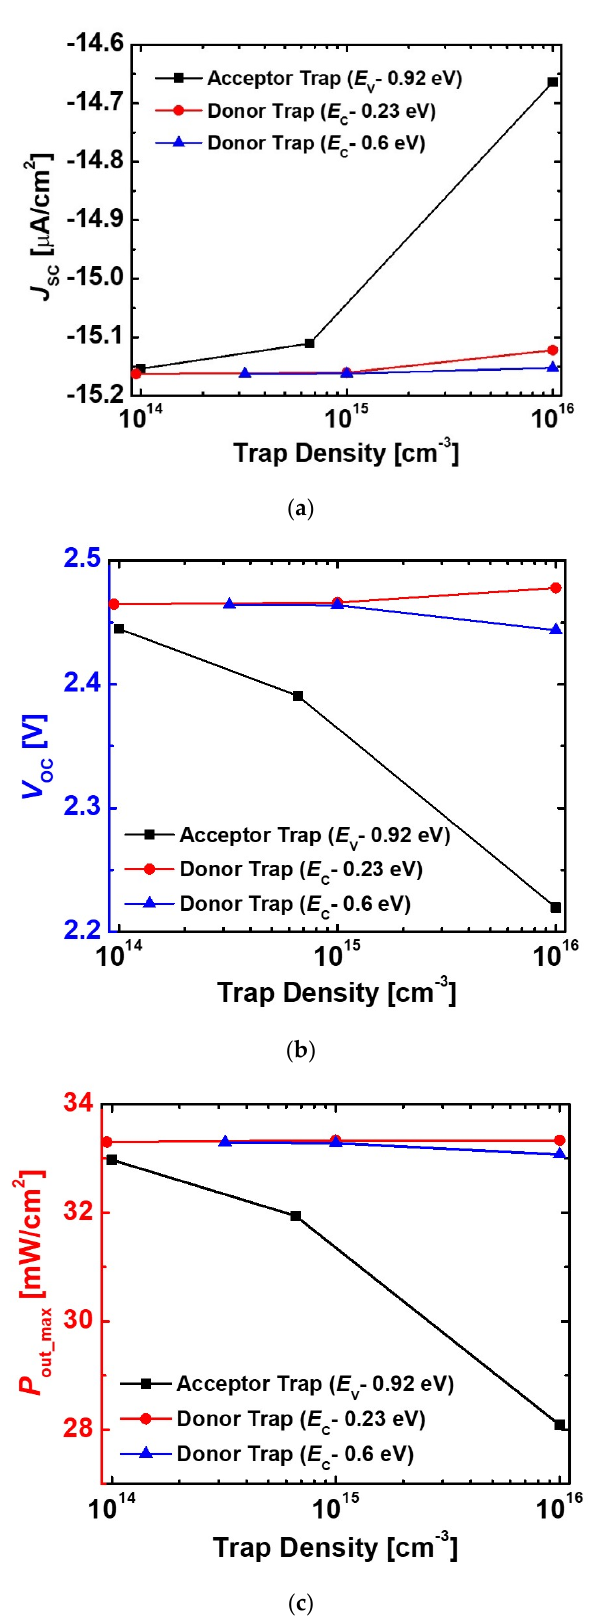
Figure 10. E ff ects of each donor and acceptor trap states on ( a ) J SC , ( b ) V OC , and ( c ) P out_max of the e-beam-irradiated diodes. The H p-GaN and H i-GaN in the diode were 100 nm and 700 nm, respectively. D p-GaN , D i-GaN , and D n-GaN were 5 × 10 17 cm − 3 , 1 × 10 16 cm − 3 , and 5 × 10 18 cm − 3 ,